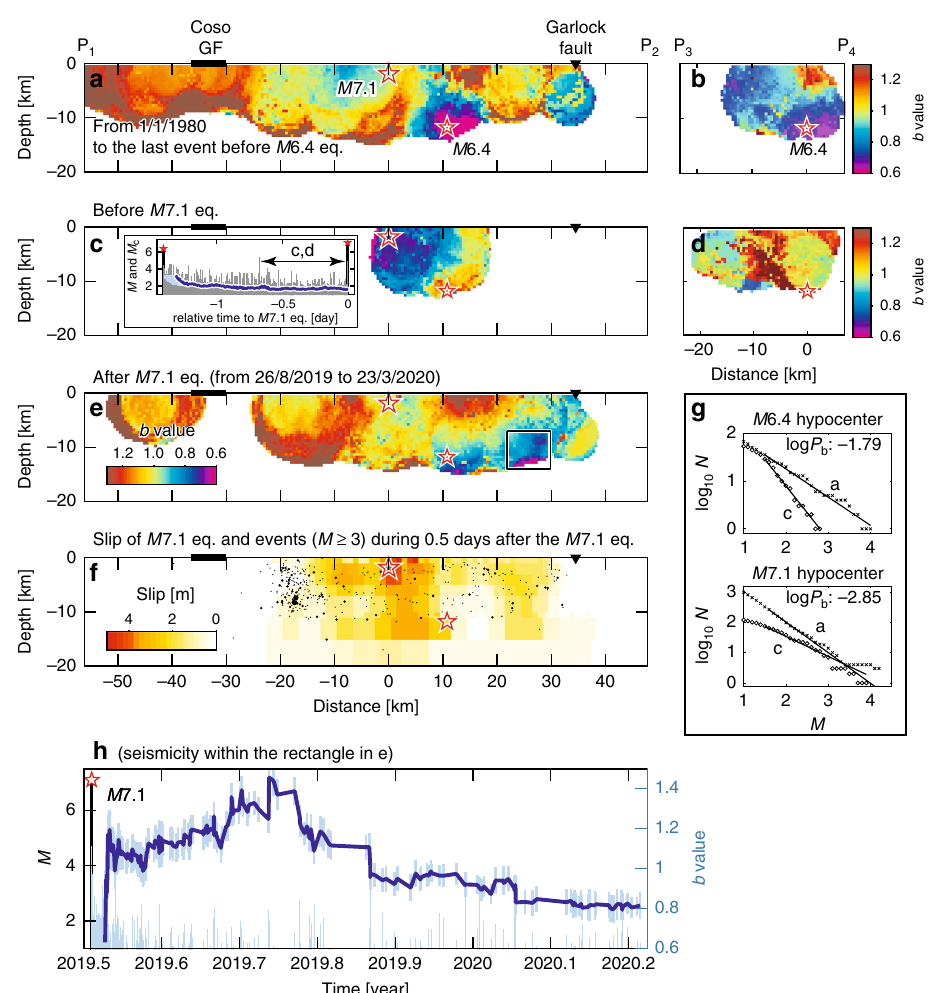
Fig. 2 Cross-sectional views of b -values. a b -values for seismicity ( M ≥ 1) before the M 6.4 quake along the fault ruptured by the M 7.1 quake. Stars shows the M 7.1 and M 6.4 hypocenters. b Same as a for the cross-section along the fault ruptured by the M 6.4 quake. c , d Same as a and b for seismicity before the M 7.1 quake. b -values were calculated for the period indicated by c, d in the inset of c from the fi rst event after the M 5.4 quake at a relative time of − 0.672 days to the last event before the M 7.1 quake. The use of seismicity soon after the M 6.4 quake was avoided to remove the effect of strong temporal variability in b . Inset: plot of M and completeness magnitude ( M c ) as a function of time relative to the M 7.1 quake (see Supplementary Fig. 7). e Same as ( a ) for seismicity after the M 7.1 quake. Events during the period from immediately after the M 7.1 quake to 25 August 2019 (or 2019.65 decimal years) were not used to calculate b -values for the same reason as ( c , d ). f Slip distribution of the M 7.1 quake 23 , and events ( M ≥ 3) that occurred in the fi rst 12 h. Symbol size is proportional to magnitude. g Top panel: frequency-magnitude distribution of earthquakes falling within a cylindrical volume with a 5 ‐ km radius, centered at the location of the M 6.4 hypocenter in ( a and c ): a with a = 2.44, b = 0.59 ± 0.17, and M c = 1.5 and c with a = 3.14, b = 1.12 ± 0.33, and M = 1.5 (for details on b -value estimation, see Methods). Bottom panel: same as the top one for the location of the M 7.1 hypocenter: a with a = 4.03, b = c 1.01 ± 0.07, and M c = 1.6, and c with a = 2.86, b = 0.66 ± 0.22, and M c = 1.5. Values of log P b ≤ -1.3 indicate a signi fi cant difference in b 48 . h Plot of b as a function of time after the M 7.1 quake for seismicity within the rectangle in ( e ). Plotting procedure is the same as that for Fig.